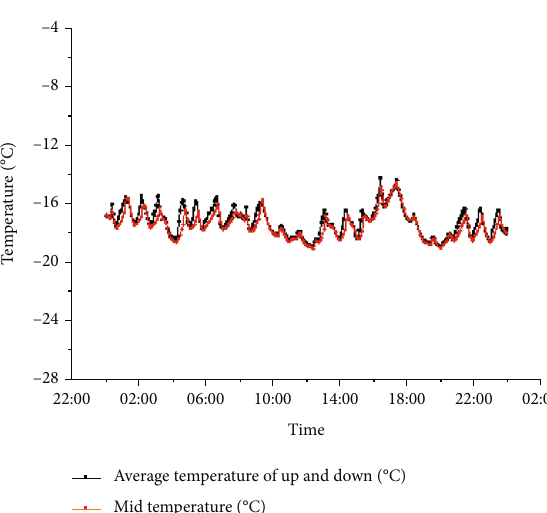
Figure 1: Average temperature and midtemperature of measuring points at vertical position 1.